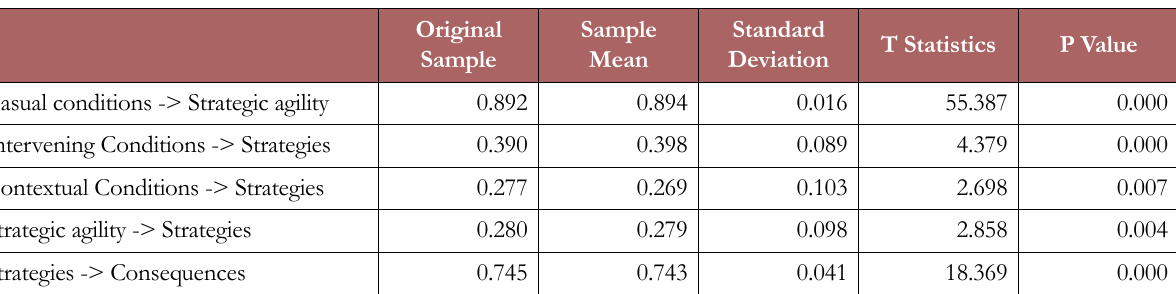
Table 16: The PLS results of the structural